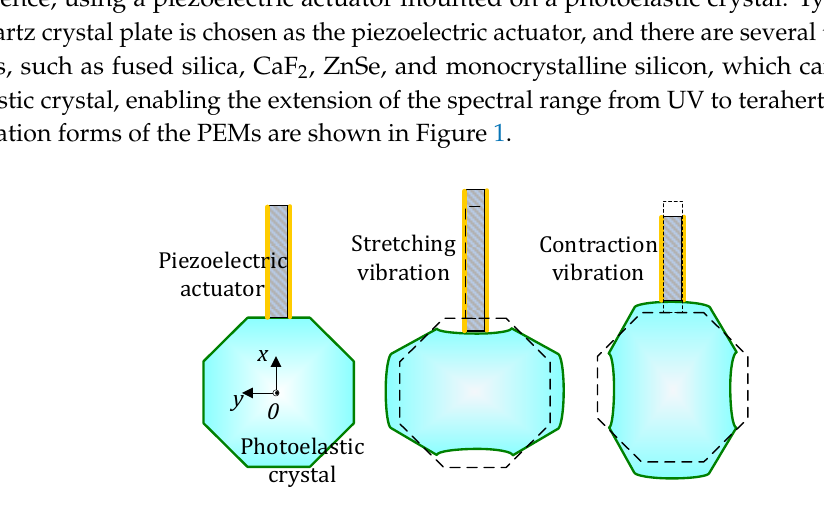
Figure 1. Schematic diagram of two-dimensional symmetric photoelastic modulators (PEMs) with stretching and contraction vibrations.